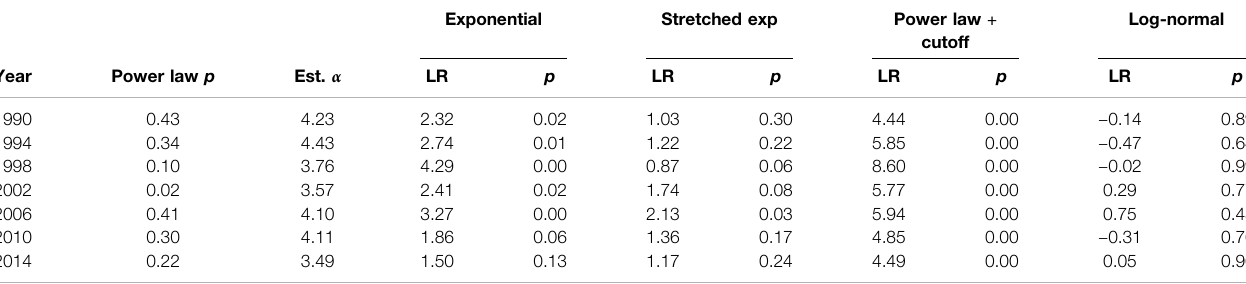
TABLE 3 | Comparisons of the fi tted power-law behavior to alternatives. Exponential Stretched exp Power law +